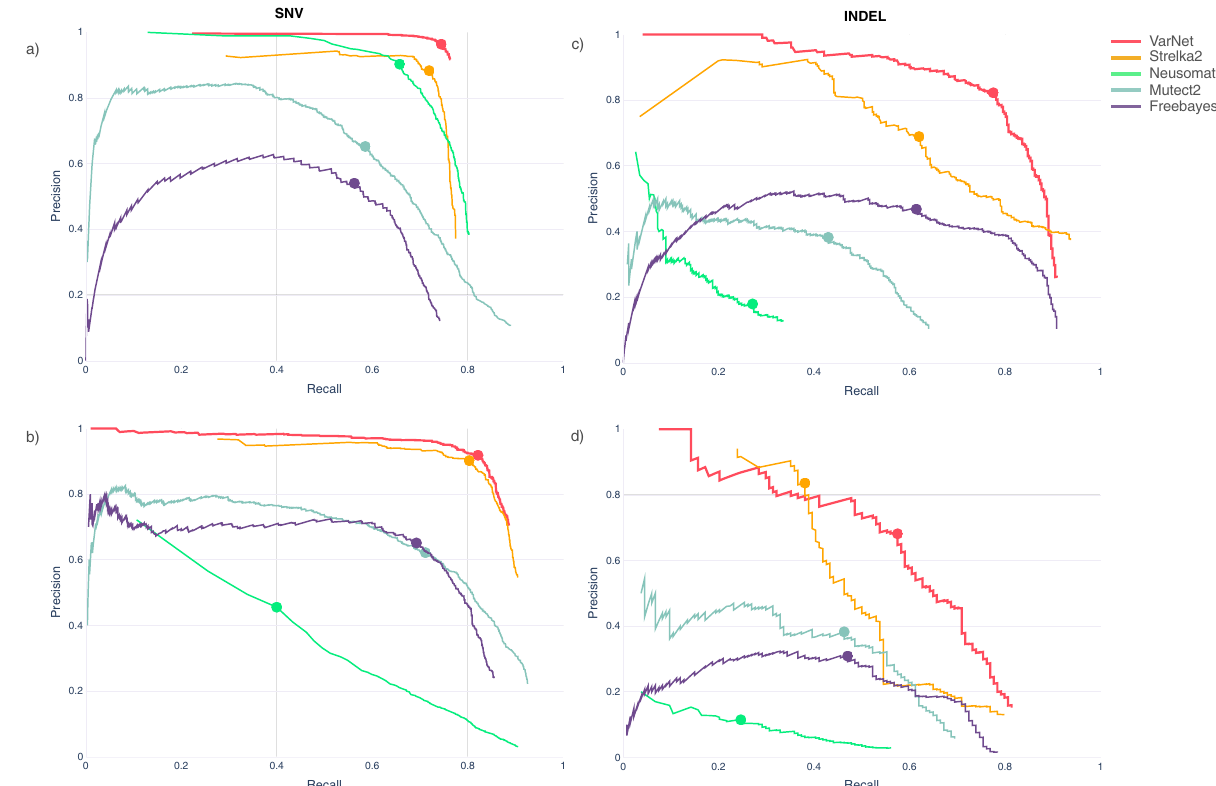
Fig. 2 Variant calling accuracy on ICGC tumors. a , b Precision/recall curves for SNV calling in the MBL and CLL samples, respectively. c , d Precision/recall curves for indel calling in the MBL and CLL samples, respectively. Solid circles indicate the highest F 1-accuracy score obtained for each method. Source data are provided as a Source Data fi VAF < 0.3, VarNet had higher accuracy (average F 1 score across CLL and MBL of 0.70) compared to Strelka2 (0.49), Mutect2 (0.31), and Freebayes (0.08). The performance of all methods